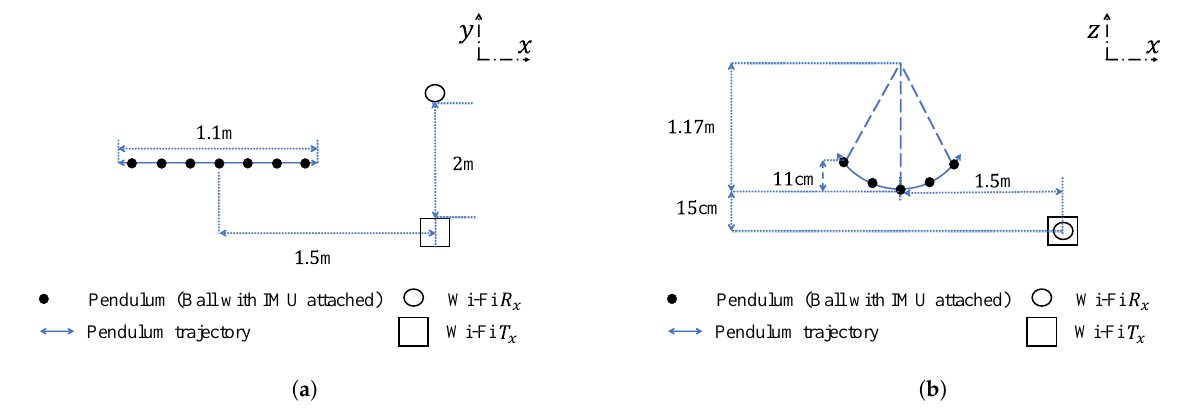
Figure 2. A presentation of the experiment scenario in the ( a ) xy plane and ( b ) xz